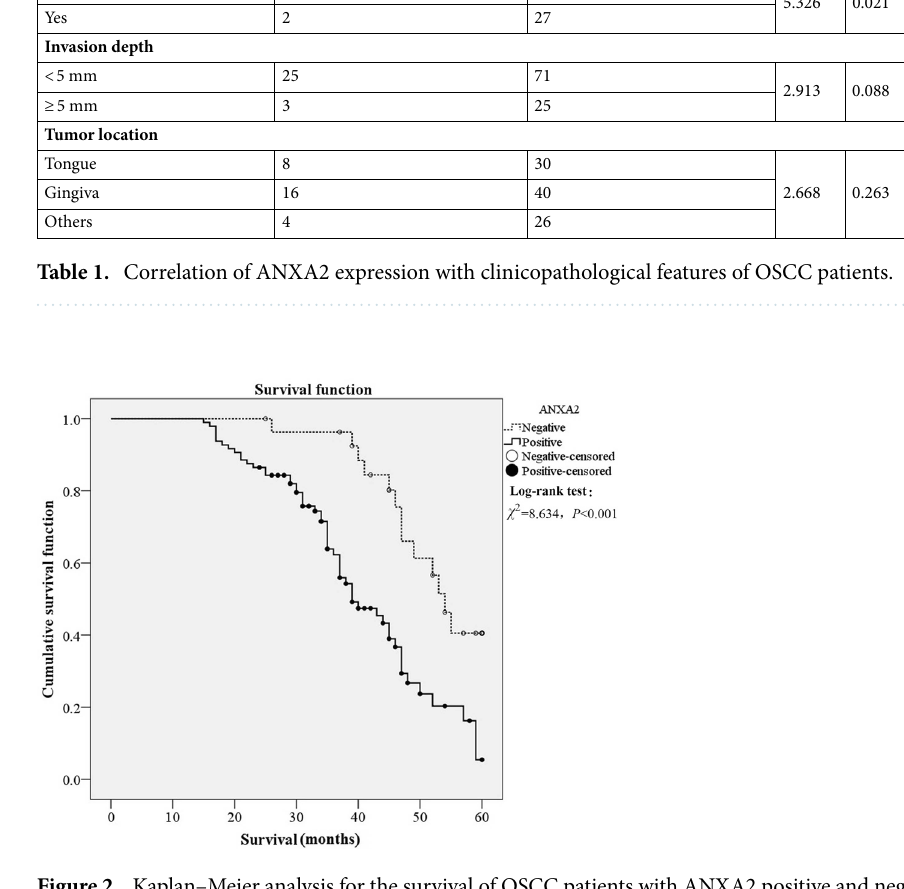
Figure 2. Kaplan–Meier analysis for the survival of OSCC patients with ANXA2 positive and negative expression. ANXA2 positive expression had a poor cumulative